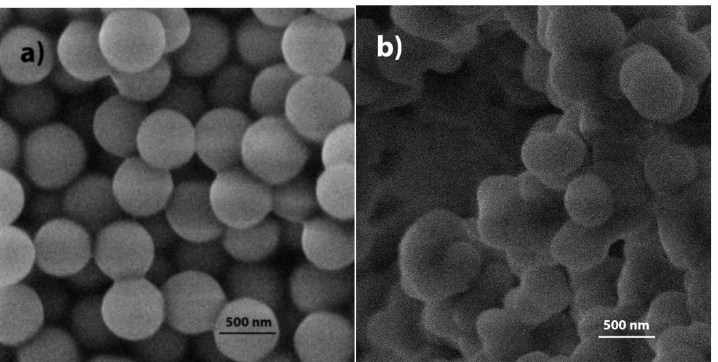
Figure 1. Scanning electron microscopy of SiO 2 –C 3 H 6 –NH 2 : ( a ) using a surfactant; ( b ) without the use of